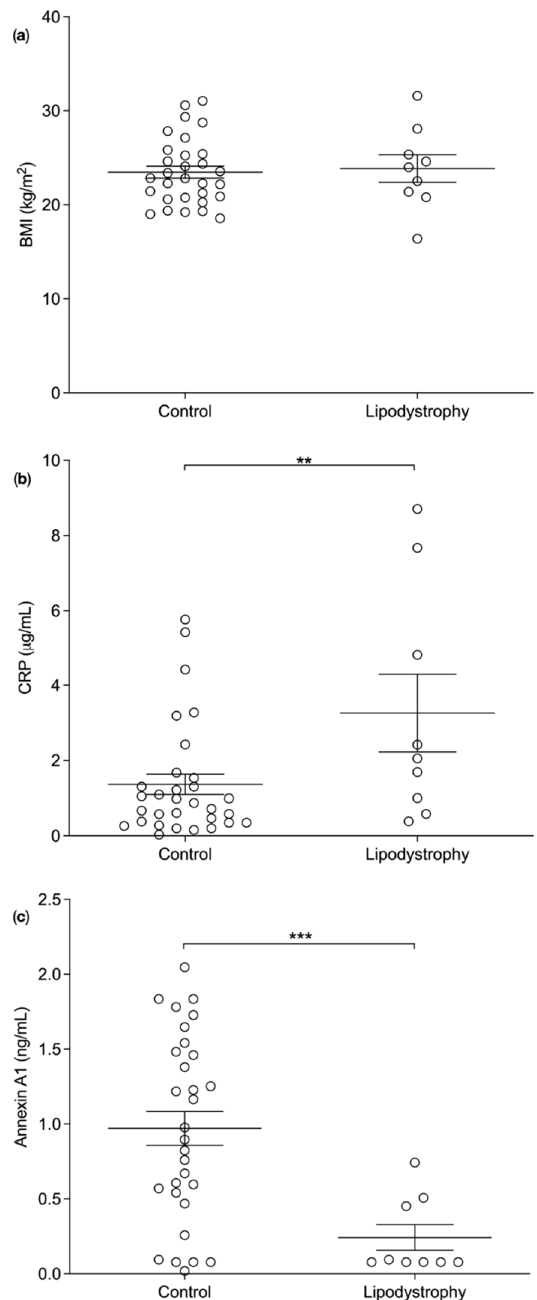
Figure 3. Average biomarker concentrations in lipodystrophy patients and matched controls. ( a ) No significant difference between the body mass index (BMI) (kg/m 2 ) of lipodystrophy patients and control was observed ( p = 0.324). ( b ) The average plasma concentration of C-reactive protein (CRP) ( µ g/mL) were significantly increased ( p = 0.0074) and ( c ) the average plasma concentration of annexin A1 (ng/mL) were significantly reduced ( p = 0.0008) in lipodystrophy patients compared to controls. One-tailed unpaired t -test was used to statistically analyse the data. Data presented as Mean ± SEM, p value was set as p < 0.05 and is denoted by ** = p = 0.001 or *** = p <